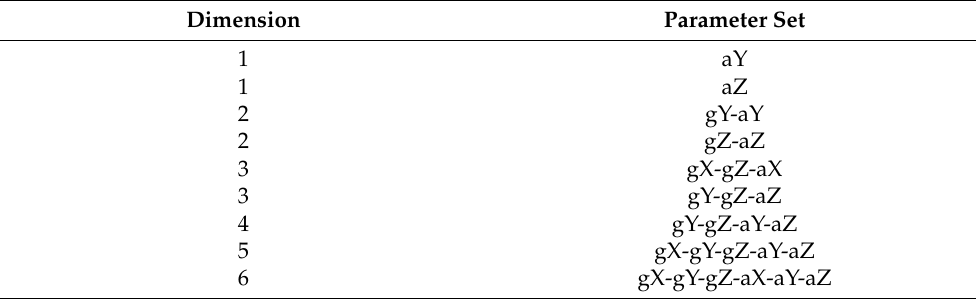
Table 2. Selection of Parameters and Dimensions.